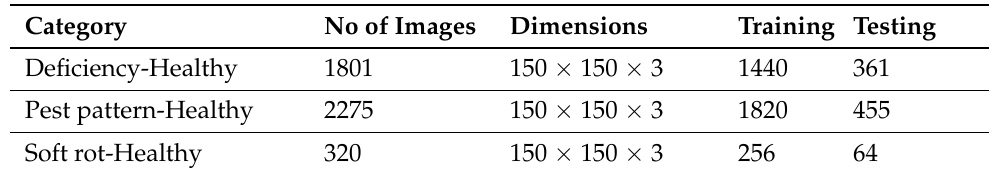
Table 3. Dataset Description